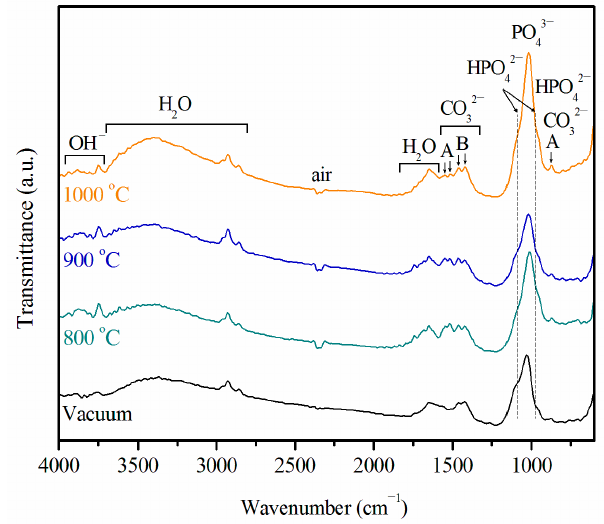
Figure 7. Fourier transform infrared (FTIR) spectra of Ti samples sintered at 800, 900, and 1000 °C in air and of a Ti sample sintered in vacuum after immersion in SBF for 21 days. A: A-type carbonate; B: B-type carbonate.